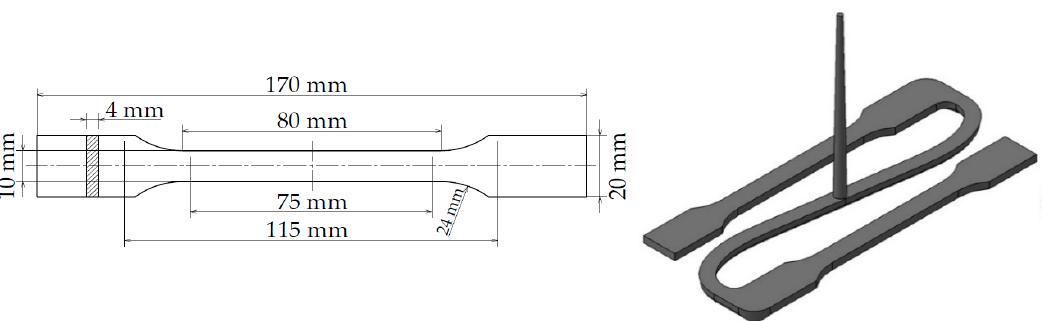
Figure 2. Melt flow path optimized tensile specimen geometry after DIN EN ISO 527 and DIN EN ISO 3167.